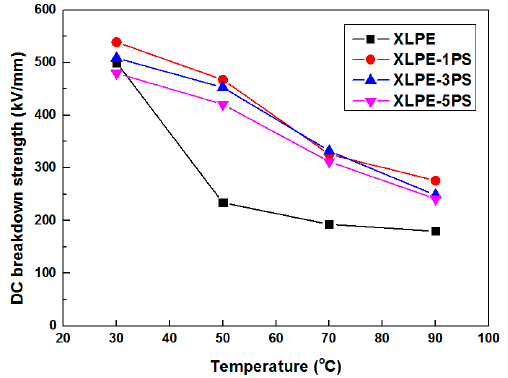
Figure 4. Temperature dependence of DC breakdown strength for samples.